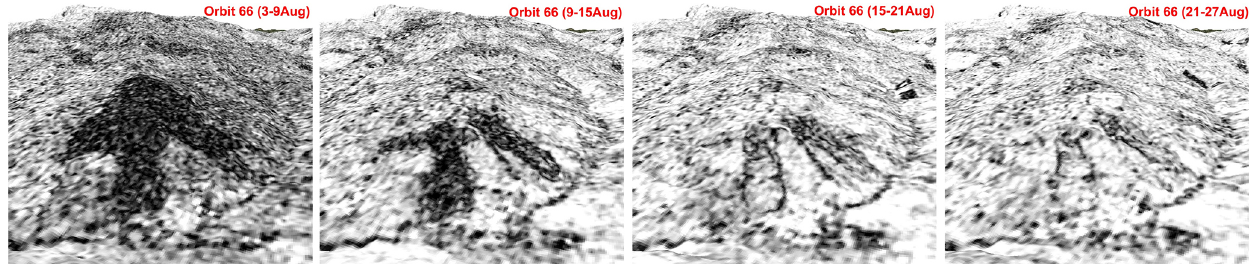
Figure 11. Coherence time series maps of the Kherba landslide, Sentinel-1.